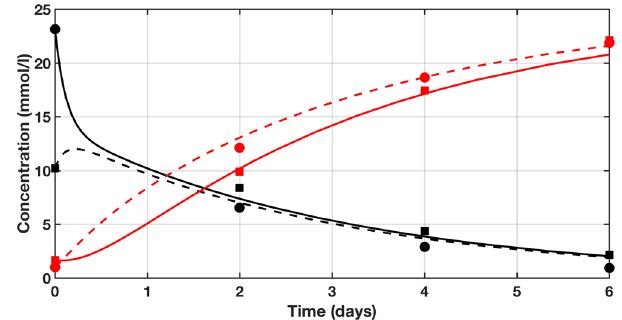
Figure 3. Computational modeling of glucose consumption and lactate production in the gut MPS. Data- driven mechanistic modeling of glucose (black) and lactate (red) in the gut MPS for the 6-day, no medium change experiment. Measurements (symbols) and simulation (lines) of concentrations in the apical side (solid lines; circles) and basal side (dashed lines; squares) of the gut MPS are shown. Triplicates were pooled together due to low apical volumes.